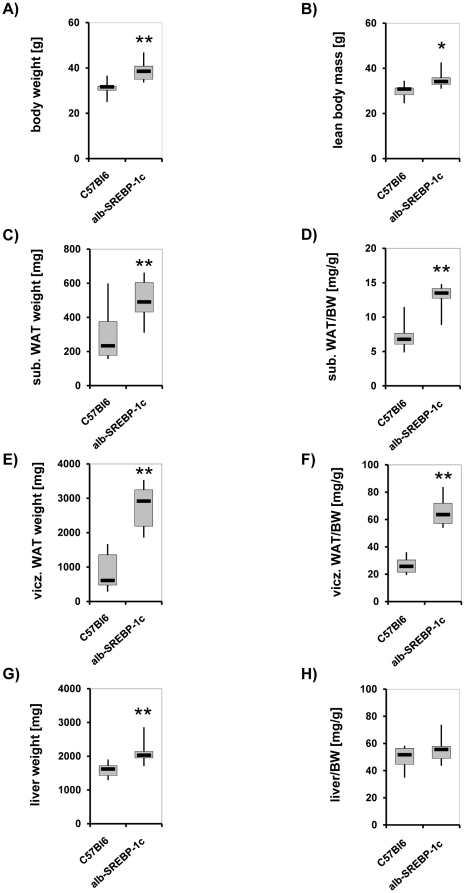
Comparison of body composition of C57Bl6 and transgenic alb-SREBP-1c animals.Body weight (A), lean body mass (B), subcutaneous adipose tissue (C), visceral adipose tissue (E) and liver weight were determined at scarification at 24 weeks of age of male mice (n = 20 per genotype) and are given directly (A, B, C, E, G) and in relation to body weight (BW) (D, F, H). C57Bl6 vs. alb-SREBP-1c mice: *p<0.05; **p<0.01.